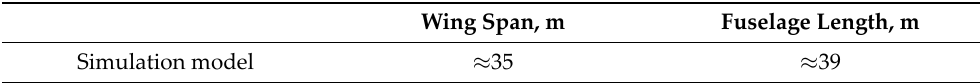
Figure 2. The wing–body interference DLM model.